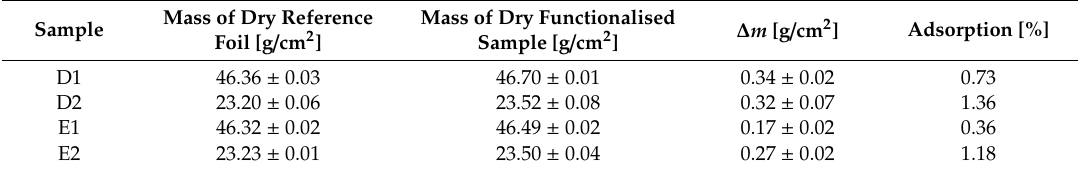
Table 5. Percentage (%) of adsorption of chitosan macromolecular solution and CSNPs RES dispersion onto the